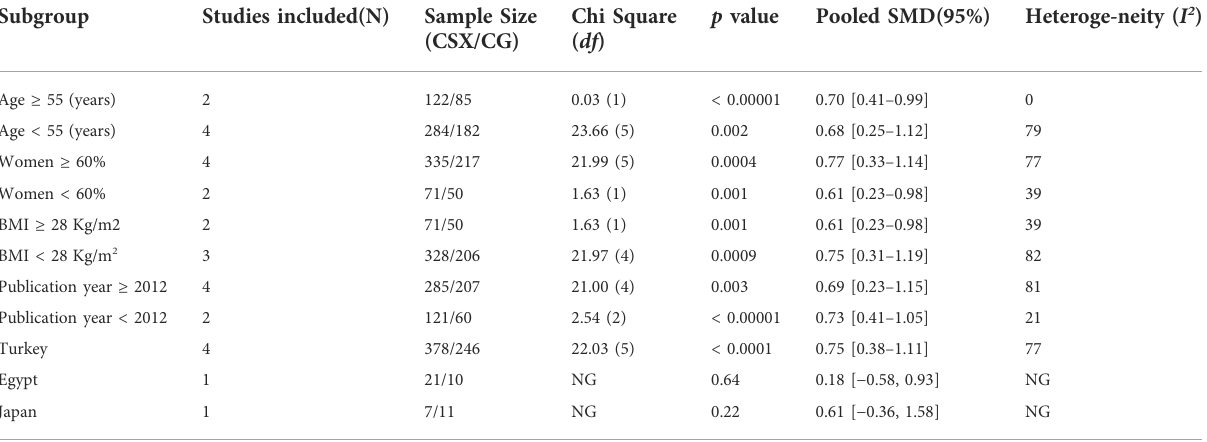
TABLE 3 Results of subgroup analysis among CSX vs.